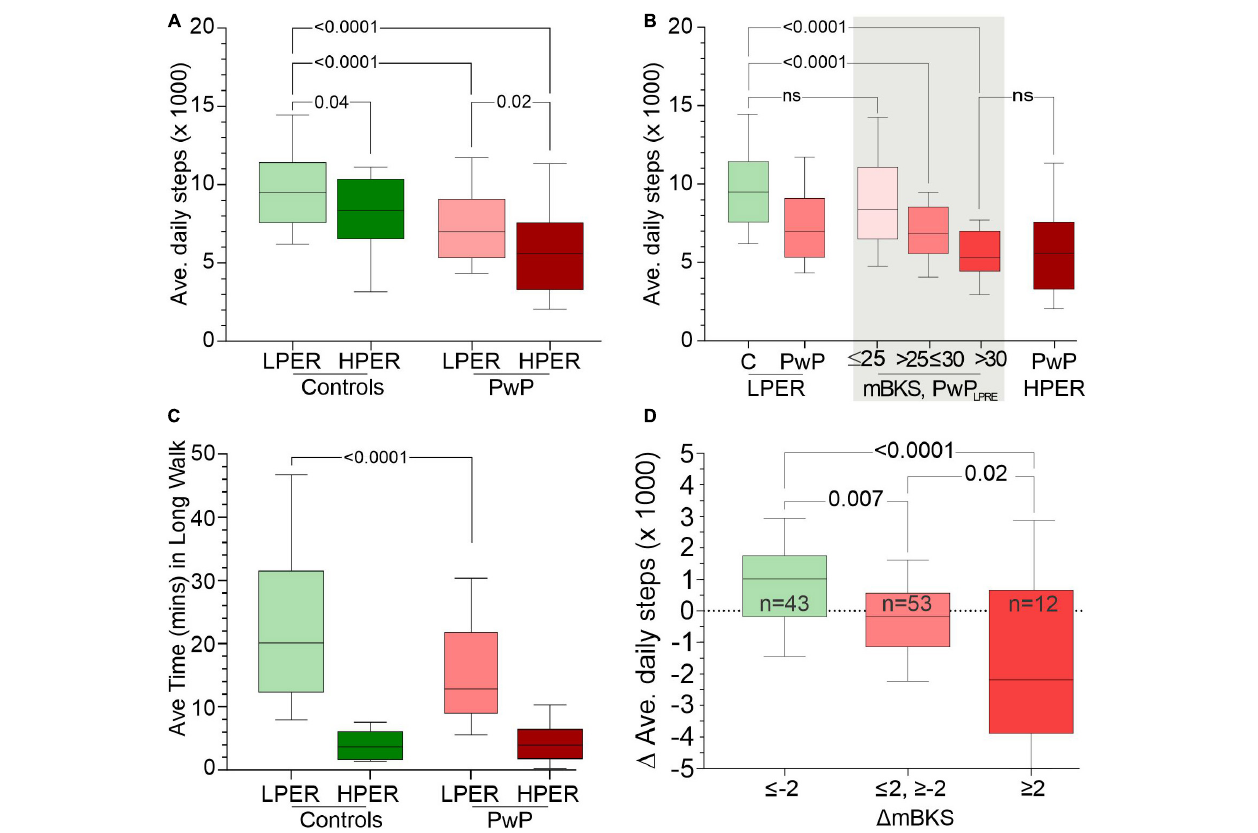
FIGURE 2 | Panel (A) shows the average daily step count ( y- axis) of C LPER , C HPER , PwP LPER , and PwP HPER participants. Panel (B) compares the average daily step count ( y- axis) of C LPER , all PwP LPER , PwP LPER stratified according to the PKG’s score for bradykinesia (mBKS) in the shade areas and PwP HPER . Note that the distribution of PwPLPRE with mBKS ≤ 25 has a similar distribution to that of C LPER , whereas those with the highest mBKS have a distribution similar to PwP HPER . Panel (C) shows the average time spent each day in long walks (walks > 1 min, y- axis) of C LPER , C HPER , PwP LPER , and PwP HPER participants. Panel (D) shows the change ( (cid:49) ) in average step count from before treatment to after treatment ( y- axis: a positive number indicates an increase in step count). PwP LPRE were sorted into three categories based on change ( (cid:49) ) in mBKS from before treatment to after treatment where a negative ( (cid:49) ) indicates an improvement in mBKS (and bradykinesia). All plots are box (median, 25th, 75th percentiles) and whiskers (10th and 90th percentiles) plots. The statistical differences between relevant plots are shown by p -values obtained from an ANOVA and Šídák’s multiple-comparisons post hoc